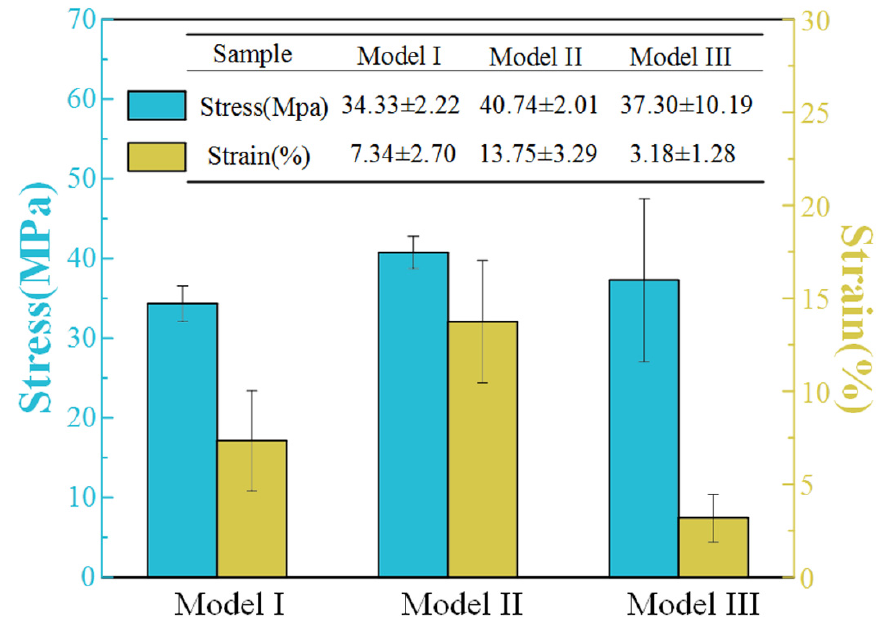
Figure 3. The tensile strength of Model I, Model II, Model